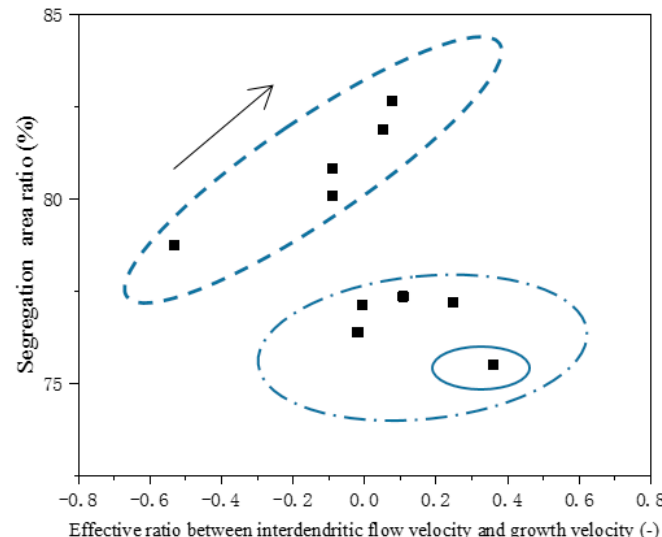
Figure 25. Relationship between segregation area ratio and the effective ratio between interdendritic flow velocity and growth velocity ( V if f / M x ) e . The equiaxed grain positions are marked by the dashed line and they show a linear increasing trend along the arrow. The columnar grain positions are marked by the dot-dash line; they also show a minor increasing trend if excluding E position marked by the full line.